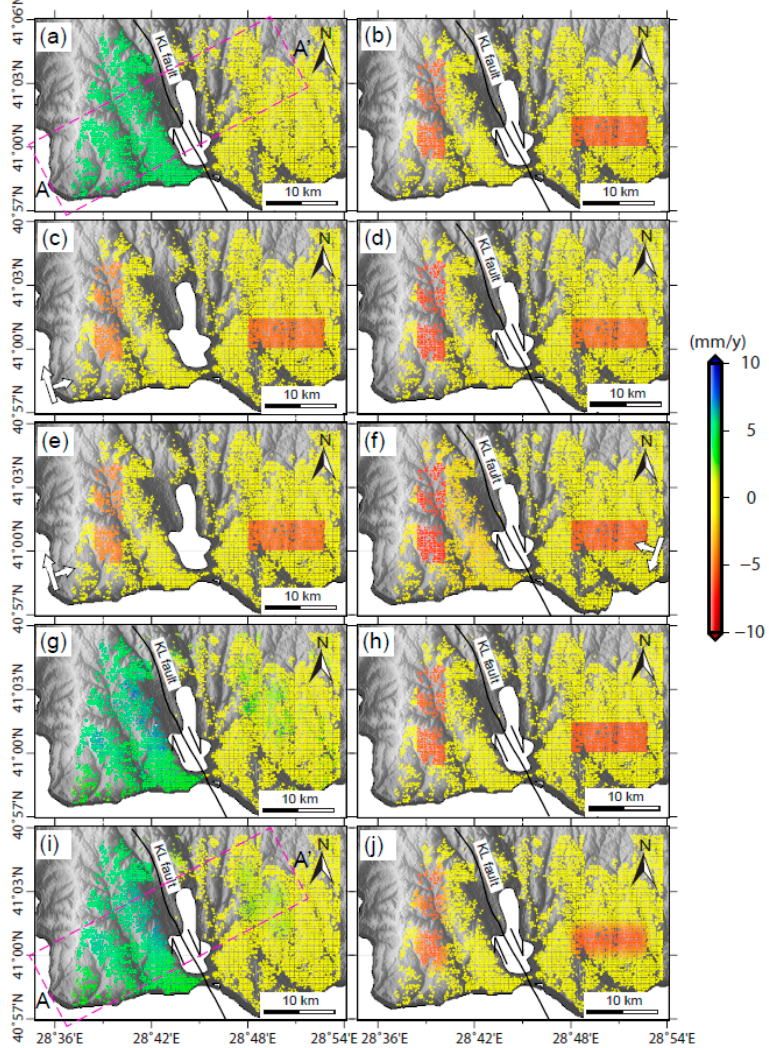
Figure A4. Similar to Figure A2, but for the synthetic test using the spatially-correlated noise instead of the Gaussian noise. ( a , b ) Synthetic horizontal ((N30°W) and vertical velocity fields; ( c , d ) Generated LOS velocity fields in the ascending and descending geometric setting; ( e , f ) Inferred from ( c , d ) by adding noise; ( g , h ) Horizontal and vertical velocity that were inverted from noised synthetic LOS velocities ( e , f ); ( i , j ) Low-pass filtered horizontal and vertical velocity field (with a filtering length of 1 km) that were obtained from ( g , h ).